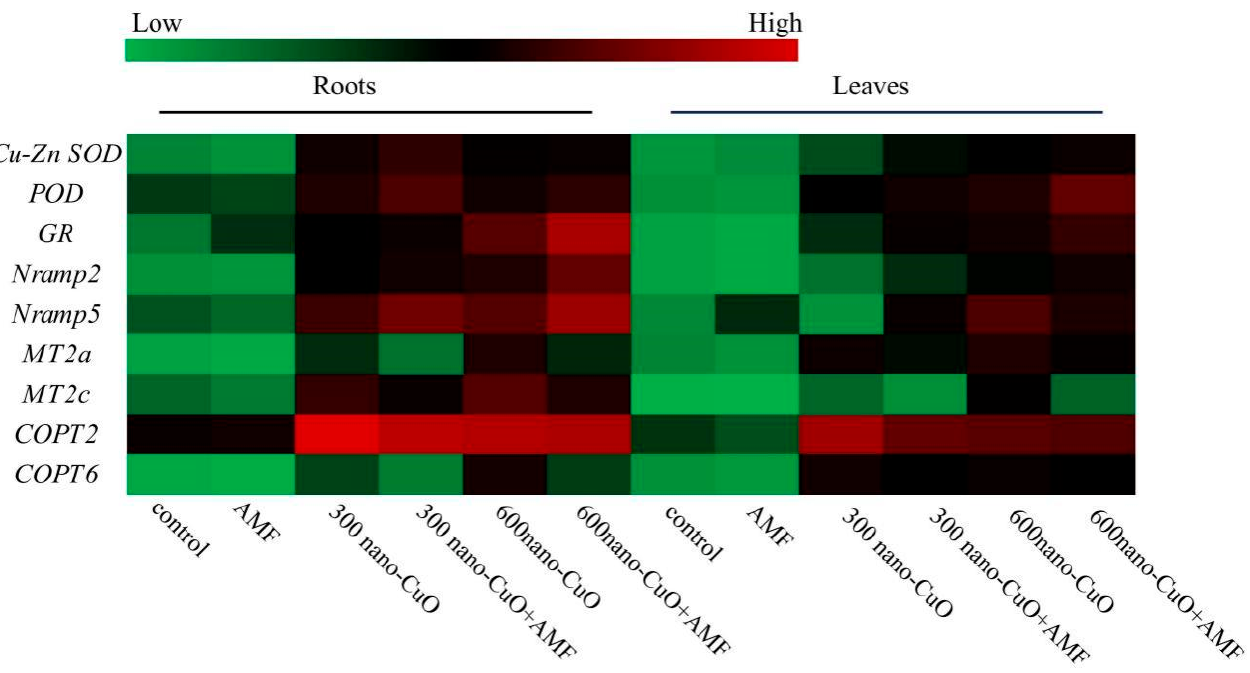
Figure 7. The effect of AMF on the expression of antioxidant enzyme-related genes and metal ion transport-related genes under nano-CuO stress in C. indica roots and leaves. Cu-Zn SOD: superoxide dismutase (Cu-Zn); GR: probable glutathione S-transferase parA; POD: peroxidase; Nramp: metal transporter Nramp; MT: metallothionein-like protein; COPT: copper transporter. Different colors represent gene expression levels from lowest (green) to highest (red) in the entire database. The RT- PCR assays were performed in three independent biological replicates and three technical replicates. genes in C. indica seedlings, consistent with the results of the organic acid concentration analysis. The expressions of MDH and CS in the AMF treatment plants were significantly AMF application might promote the secretion of malic and citric acids in C. indica